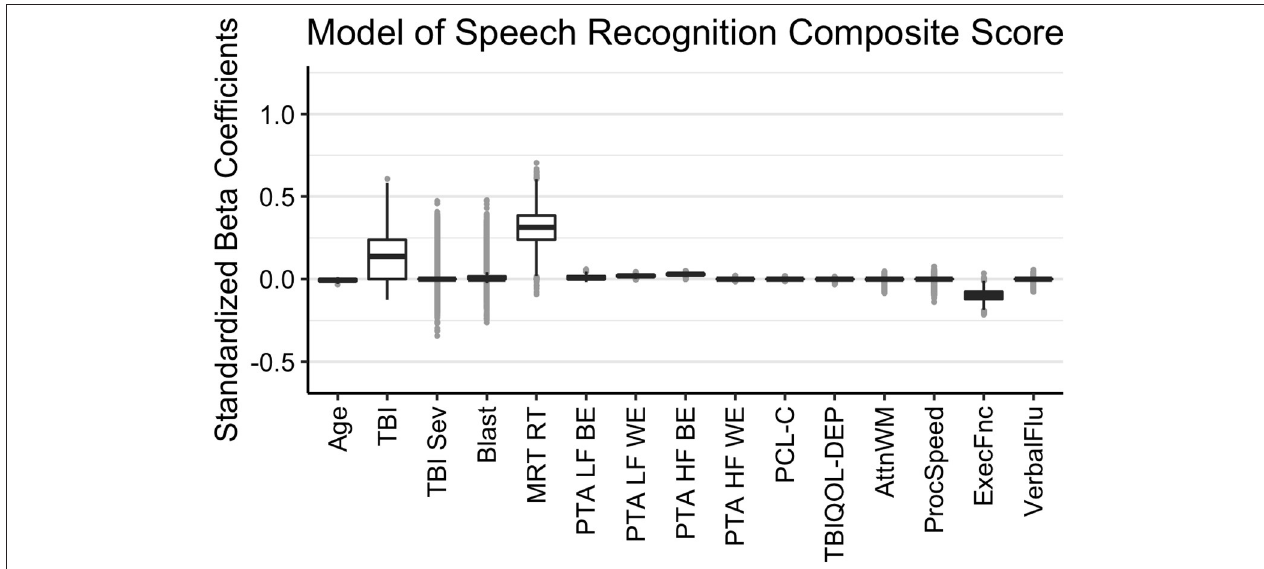
FIGURE 1 | Regression coefficients for the Speech Recognition Composite model. Median intercept (mu) = − 0.10 (Q1 = − 0.47, Q3 = 0.27).